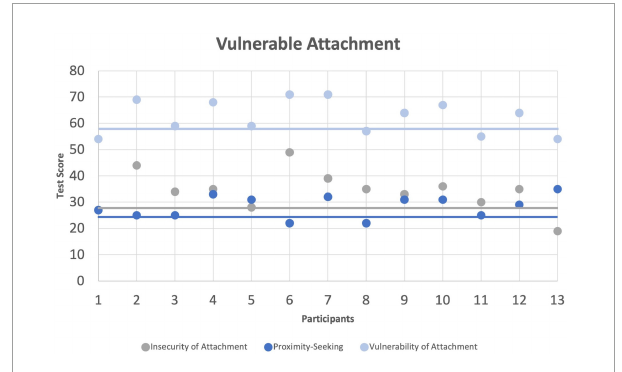
FIGURE5 Vulnerable Attachment Style Questionnaire (VASQ). Individual scores in the VASQ. Lines indicate VASQ cutoff values for the respective